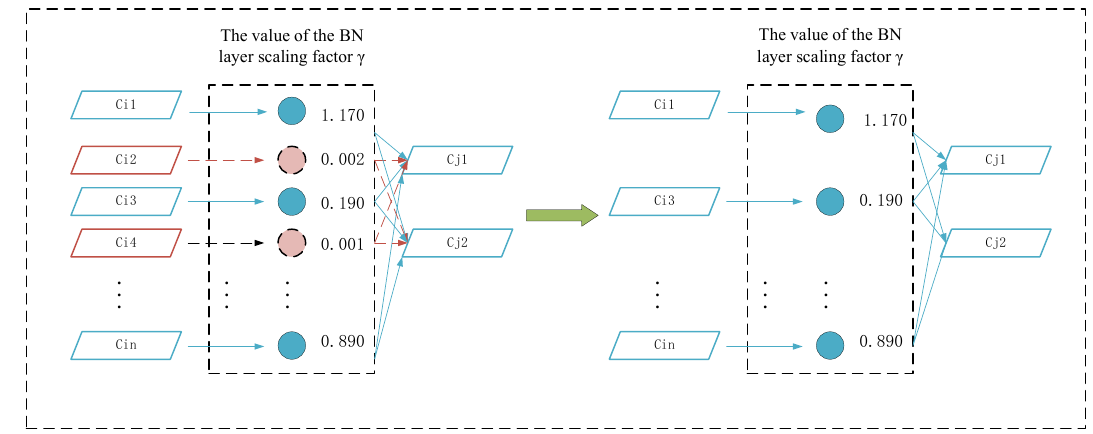
Figure 5. Schematic diagram of channel pruning.